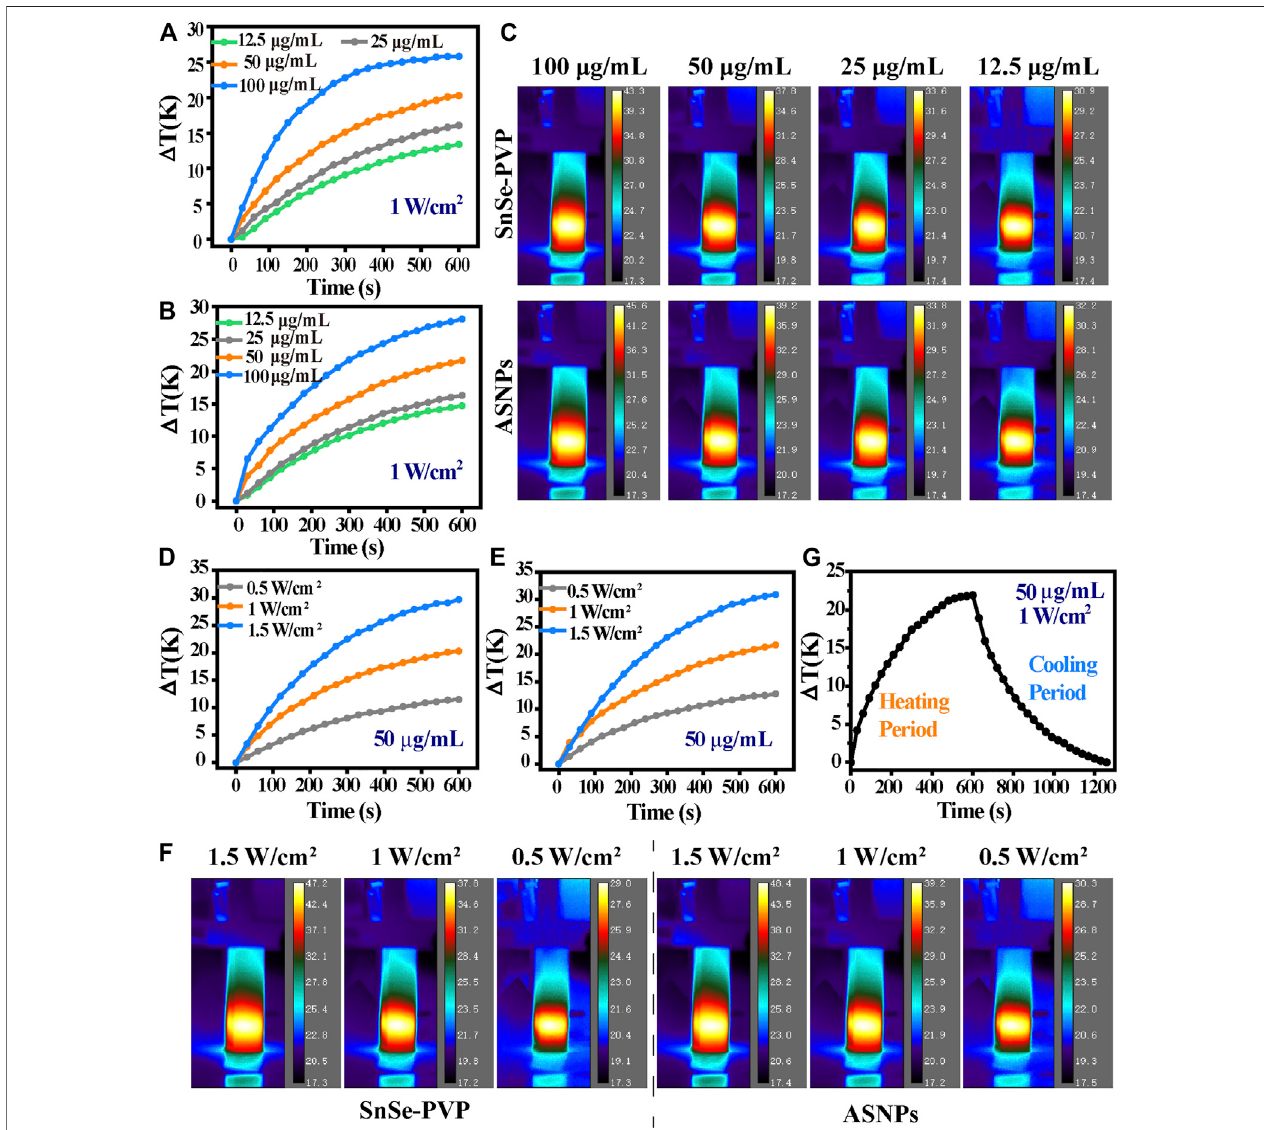
FIGURE3| Characterization ofphotothermalconversion properties. Temperature curve asafunction oftime of (A) SnSe – PVP, (B) ASNPs solutions (12.5,25, 50, and 100 μ g/mL) with808-nmlaserirradiation(1 W/cm 2 ),and (C) thecorresponding thermalimaging fi gureatthemaximumstabletemperature.Temperature curveasa function of time of (D) SnSe – PVP, (E) ASNPs solutions (50 μ g/mL) with 808-nm laser irradiation at various laser intensities (0.5, 1, and 1.5 W/cm 2 ), and (F) correspondingthermal imaging fi gure at themaximum stable temperature. (G) TemperaturecurveasafunctionoftimeofASNPssolution(50 μ g/mL):under808-nm laser irradiation (1 W/cm 2 ) to a maximum stable temperature (heating period); naturally cooling to a stable temperature without laser irradiation (cooling period).